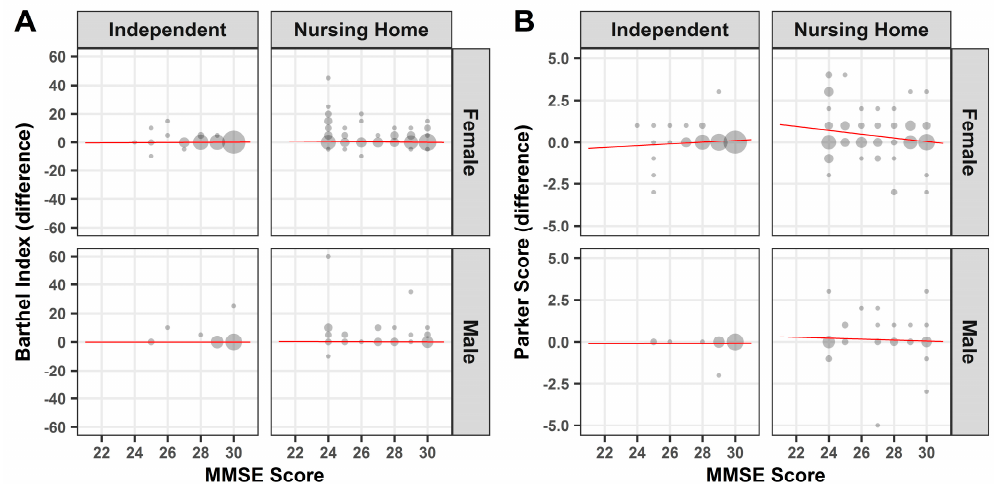
Figure 4. Mini Mental Status Test—Correlation: Point plot illustration of Barthel Index ( A ) or Parker Mobility Score ( B ) against the Mini Mental Status Test. Red line: linear regression.